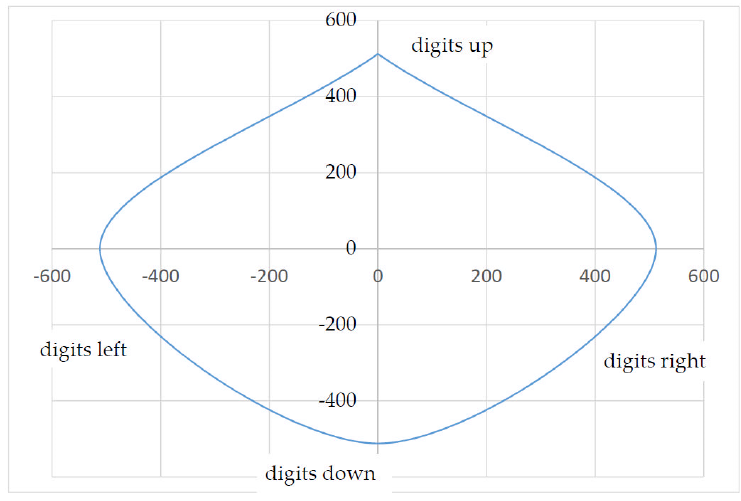
Figure 13. Output data curve. Table 4. Maximum patient measurements and calculated output